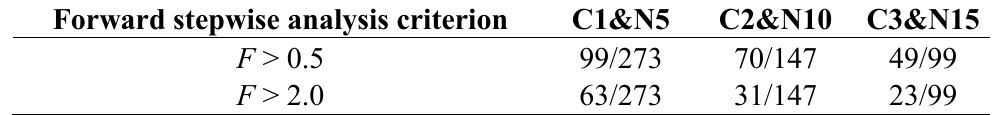
Table 2. SDAR LDA model for CYP3A4 showing number of bins selected/number of bins available.